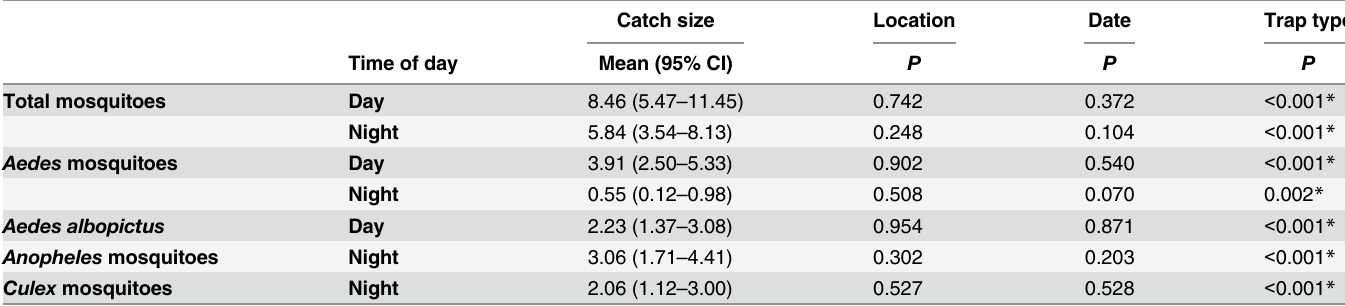
Results are shown for day (n = 16) and night (n = 16) collections, for all locations (n = 8), for all collection dates (n = 8) and for all trap types (n = 4). As the catch sizes were too low, no night values for Aedes albopictus and no day values for Anopheles and Culex mosquitoes are shown. CI, Con fi dence